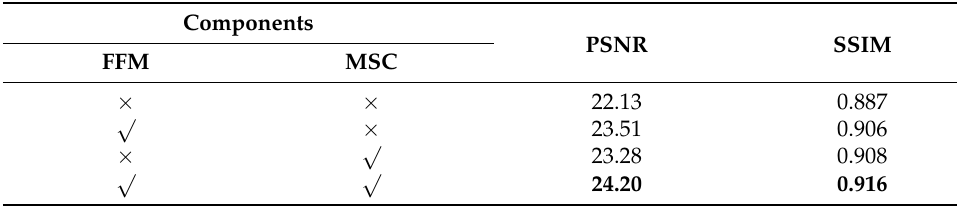
Table 5. Quantitative results on the SOTS. FFM, and MSC denoting the feature fusion module and multi-scale skip connection based on the residual network, respectively. structure and × indicates the absence of a structure.